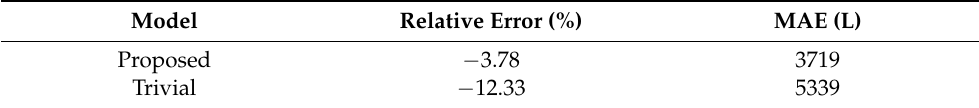
Table 4. Medium-term prediction error of the proposed and trivial models—prediction of the total demand for gas in a 3-month period for a distribution station serving 749 customers. Model Relative Error (%)